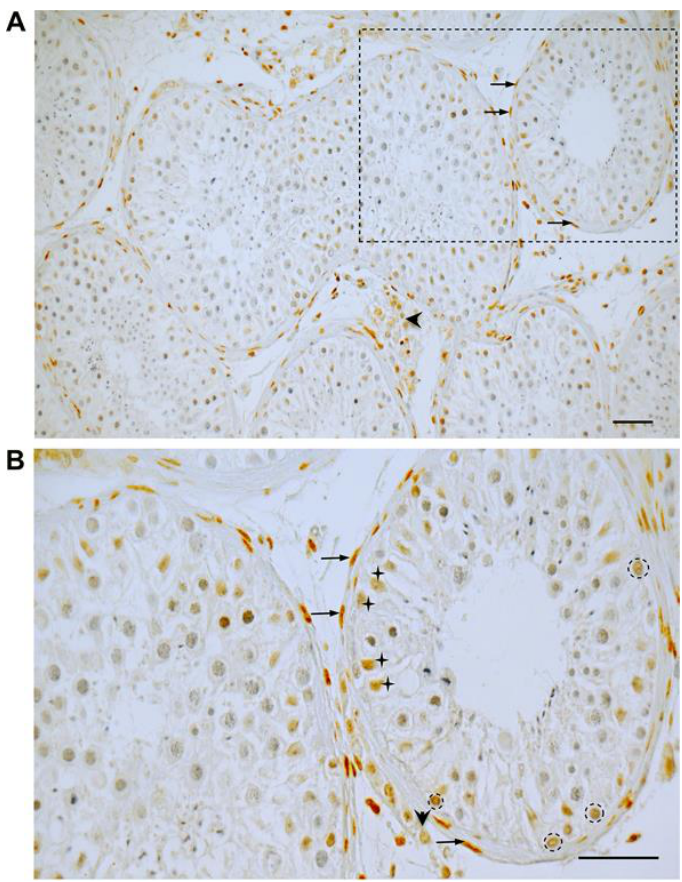
Figure 1. Immunohistochemistry of GR in the human testis ( A , B = boxed area in A). In a representative human testicular biopsy, GR staining is found in peritubular, myoid cells (arrows in A,B) building the wall of seminiferous tubules, in some Sertoli cells (crosses, B) and some spermatogonia (circles, B). In addition, various interstitial cells, presumably Leydig cells (arrowheads in A,B), but also macrophages and endothelial cells of blood vessels, are immuno-positive. Nuclei were slightly stained with Hematoxylin. Scale bars = 50 µm.